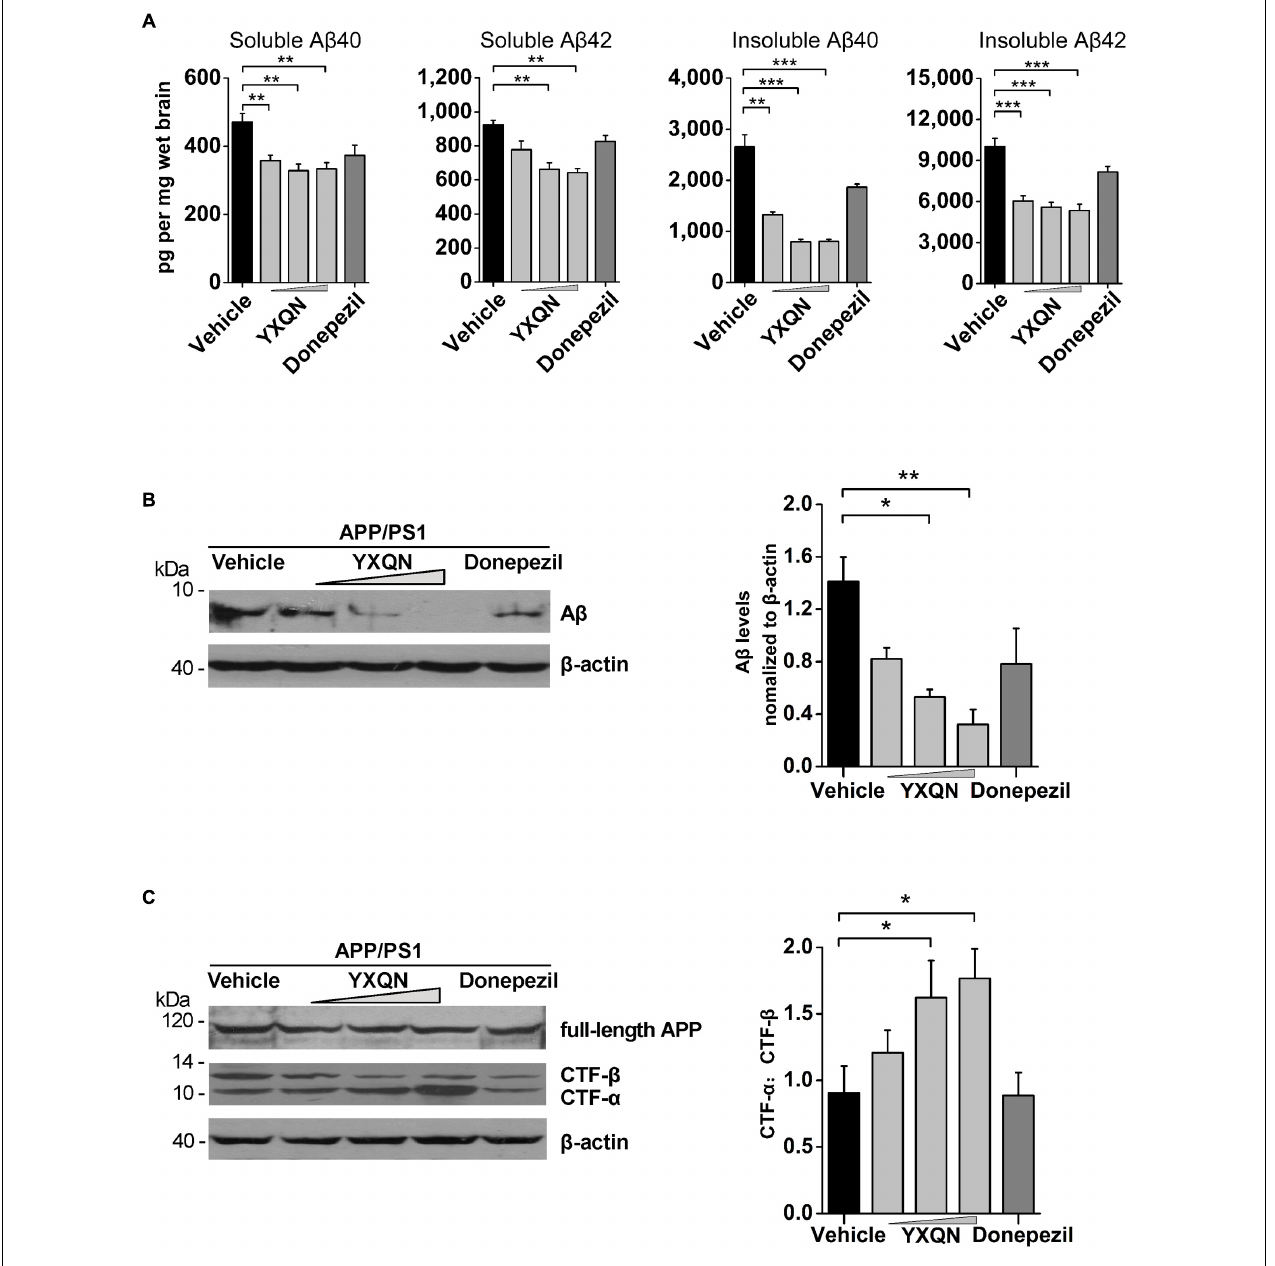
FIGURE 6 | Effects of YXQN on cerebral A β levels and APP process in APP/PS1 mice. (A) The levels of formic acid-soluble (insoluble) and SDS-soluble (soluble) A β 40 and A β 42 in brain homogenates from YXQN administration from 8- to 10-month old using ELISA kits ( n = 16–18). (B) The levels of total A β in the RIPA brain extracts of 10-month-old APP/PS1 mice analyzed by Western blot with antibody 6E10 ( β -actin as internal controls). (C) The expression of full-length APP and carboxyl-terminal fragments (CTFs) analyzed by immunoblot with the APPct antibody and densitometric scanning, and quantified by ratio of C-terminal α -cleavage product (CTF- α ) and β -cleavage product (CTF- β ). Western blot images and densitometric quantification of blots is from at least three independent experiments ( n = 6 mice per group). The drug dosages from low to high of YXQN extract are 0.69, 2.08, and 6.24 g/kg. The numbers presented are mean ± S.E.M. (Dunnet’s post